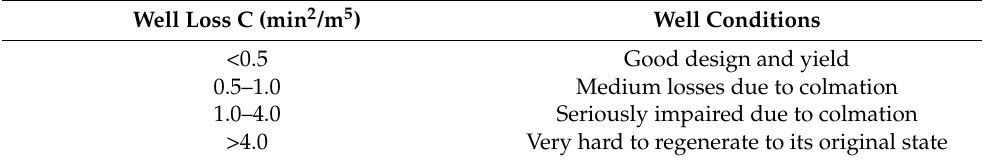
Table 1. Relationship between parameter C and well condition (Walton, 1970).